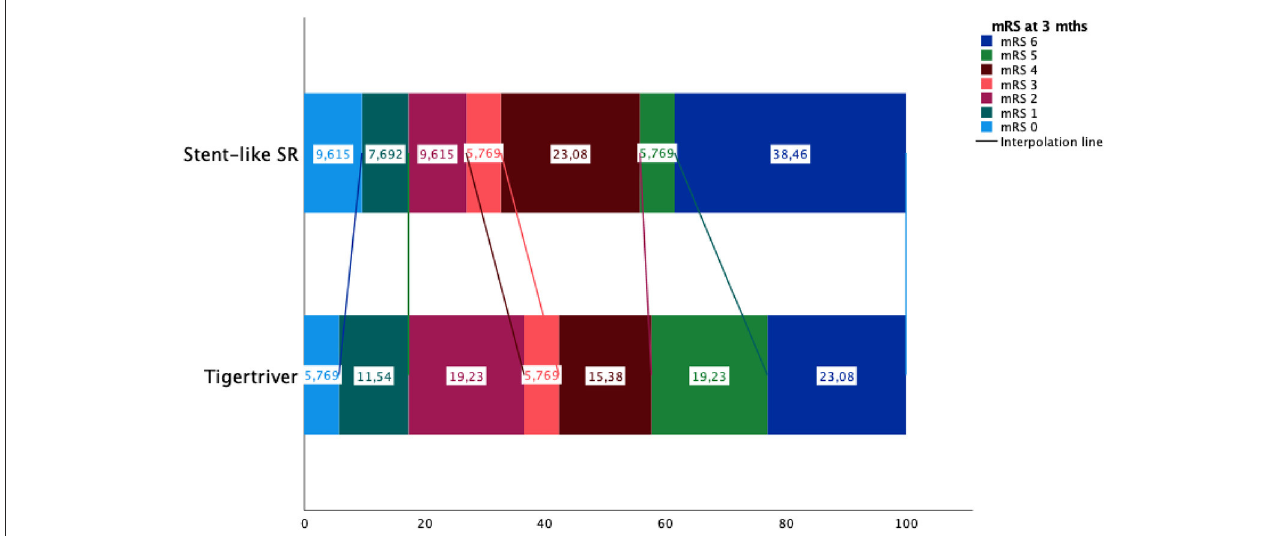
FIGURE3 Patients’ mRS status after 3 months in Tigetriever and stent-like stent-retrievers